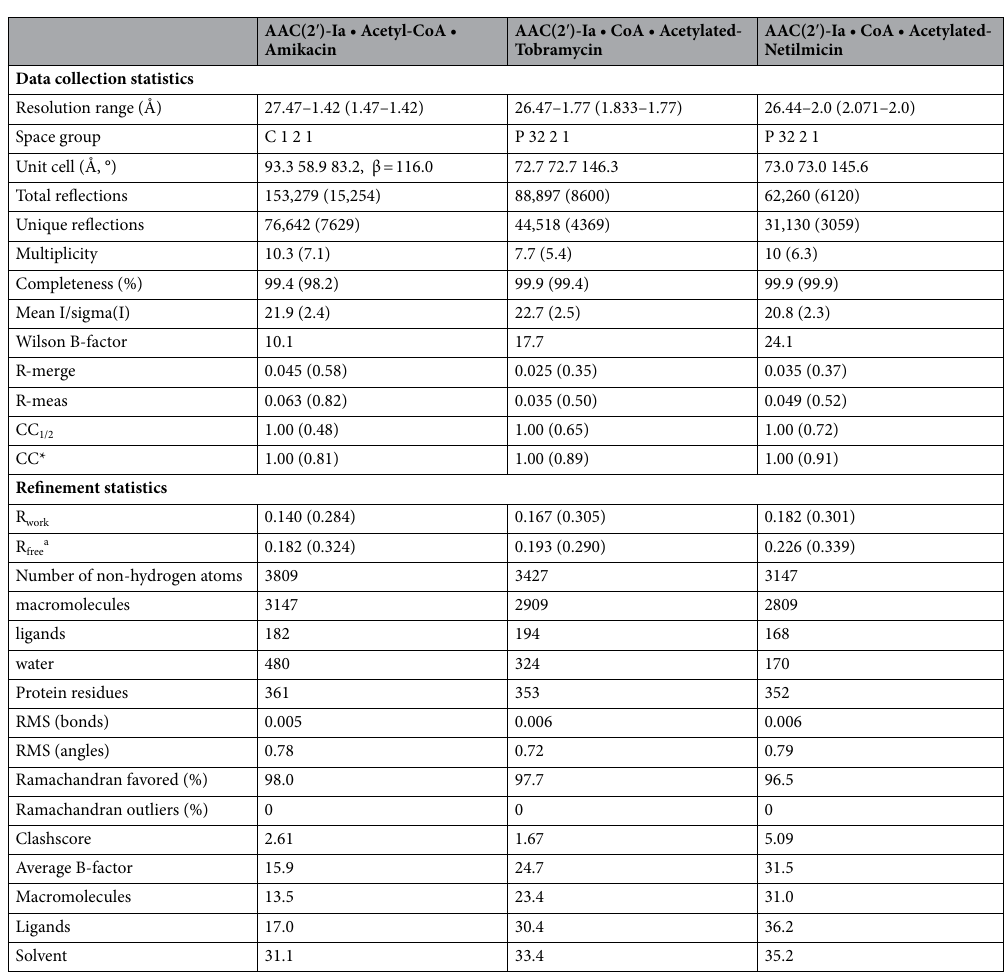
Table 1. Data Collection and Refinement Statistics of Aminoglycoside-AAC(2 ′ )-Ia Complexes. Statistics for the highest resolution shell are shown in parentheses. a R free was calculated by randomly omitting 10% of observed reflections from refinement.